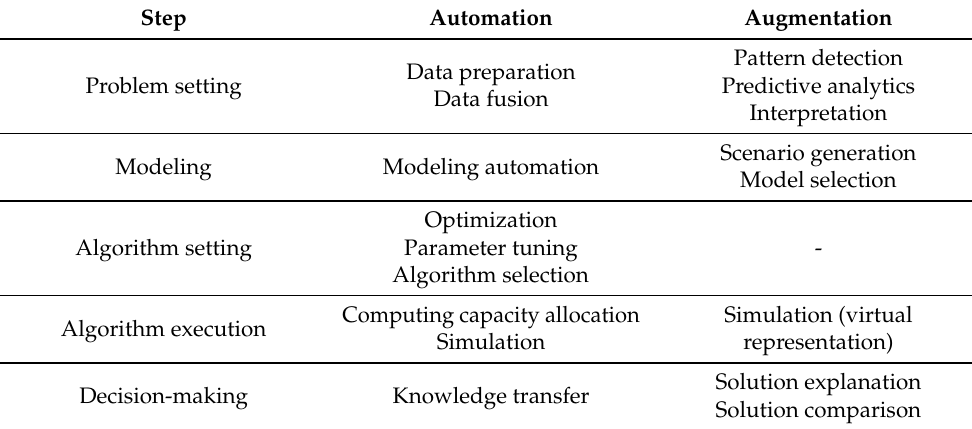
Table 2. A summary of AI usage in the AHMSS